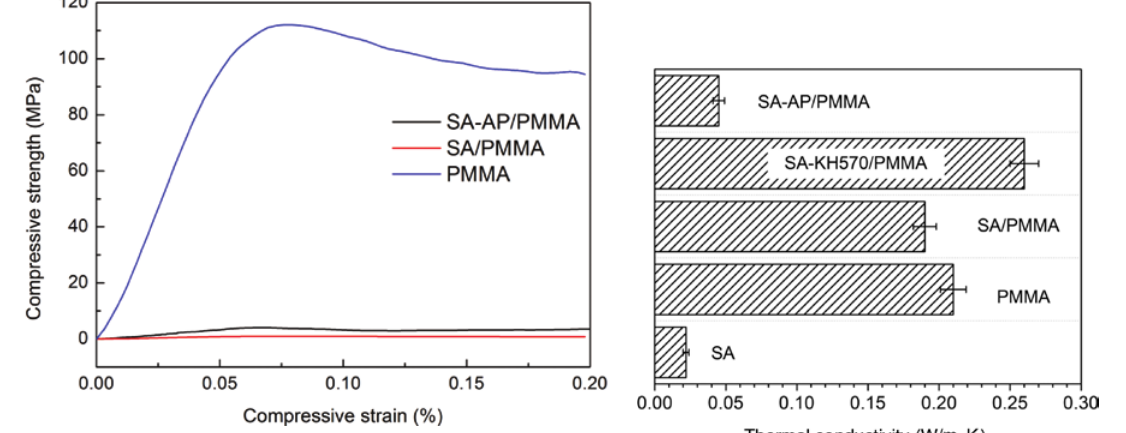
Figure 7: Compressive strength of poly(methyl methacrylate) (PMMA), silica aerogel (SA)/PMMA and SA-amino-capped polydivi- nylsiloxane (AP)/PMMA.